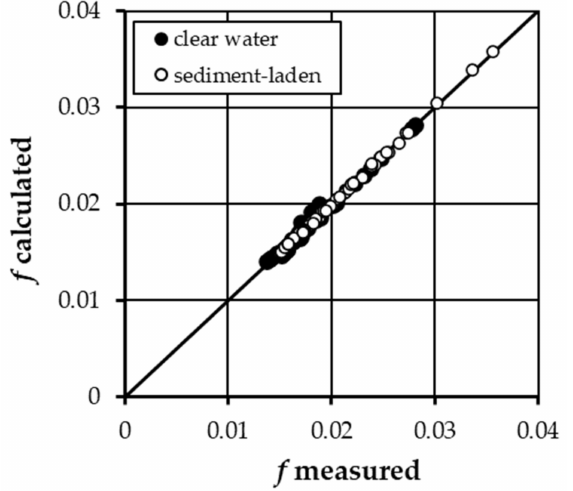
Figure 8. Comparison between the f values for clear water and sediment-laden